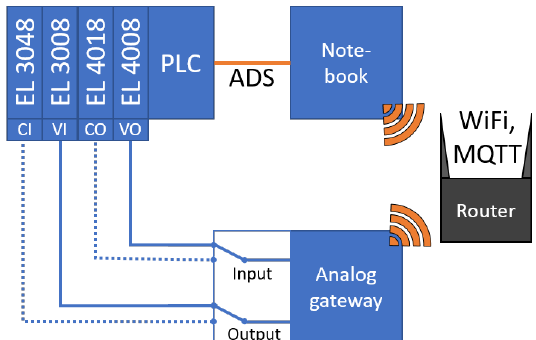
Figure 4. Validation setup for the AGW’s performance. The communication between the pro- grammable logic controller (PLC) and notebook or the AGW and notebook, respectively, is realized by automation design specification (ADS) and the message queuing telemetry transport (MQTT) protocol. The PLC terminals are specified as CI = current input, VI = voltage input, CO = current output, VO = voltage